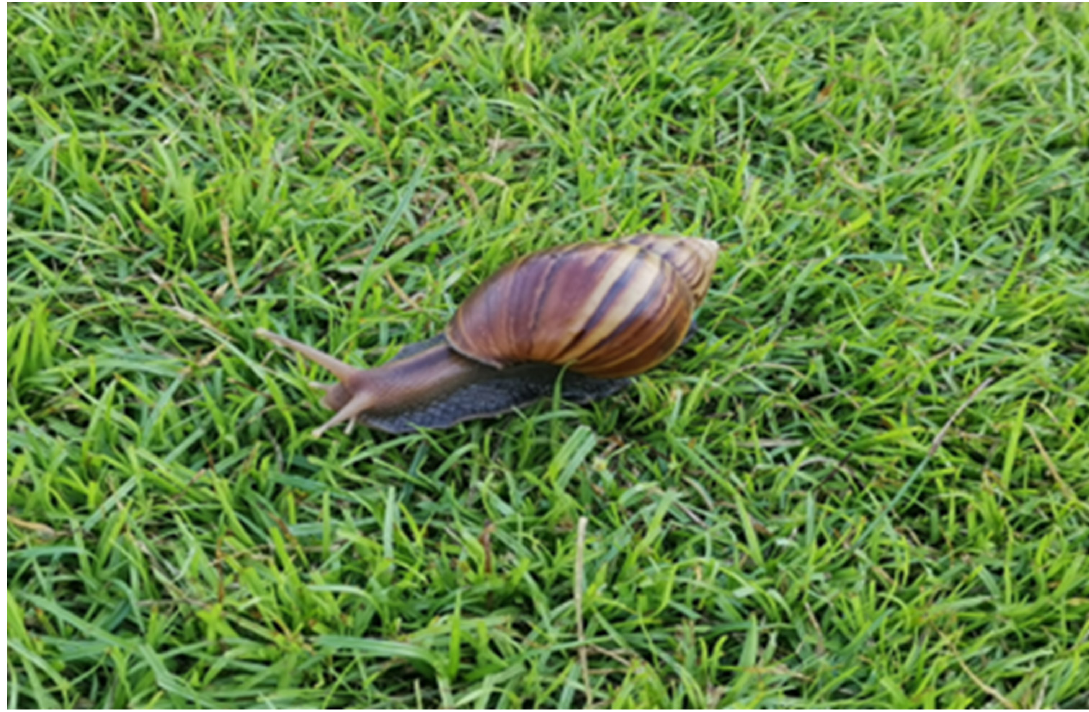
Figure 7. Photograph by Participant I.